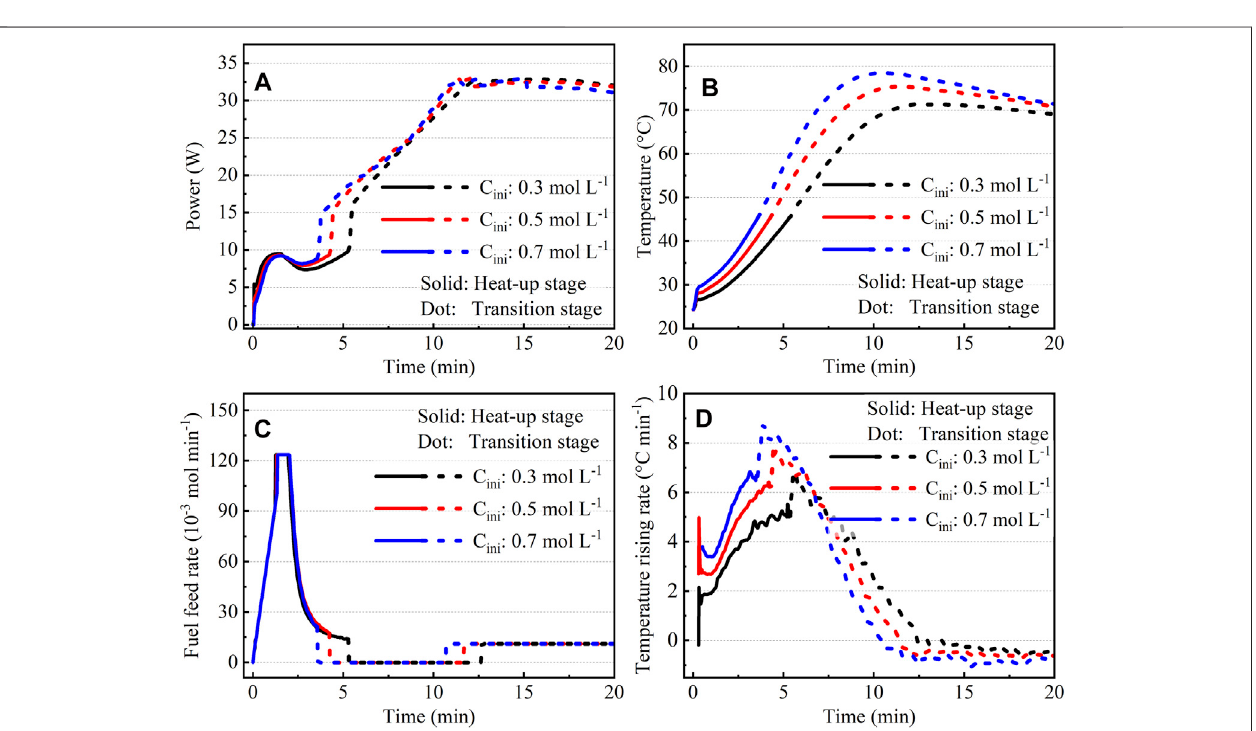
FIGURE 5 | Pro fi les of the (A) power, (B) temperature, (C) fuel feed rate, and (D) temperature rising rate of the DMFC during startups at various initial concentrations. T ini : 23 °